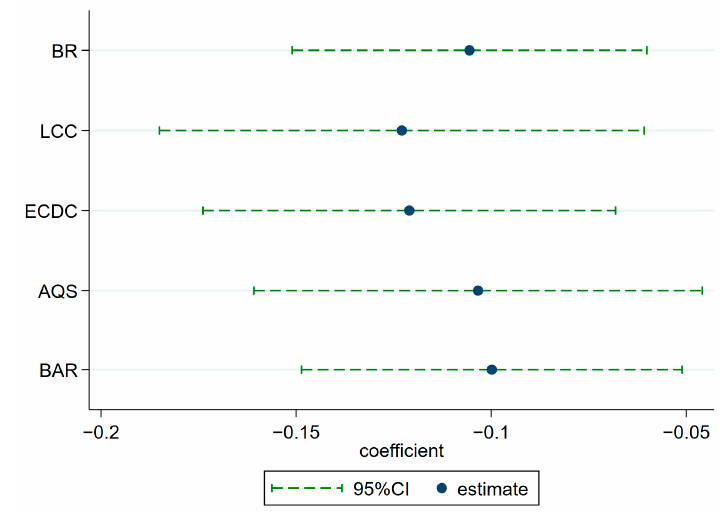
Figure 5. Controlling for other policy disruptions.